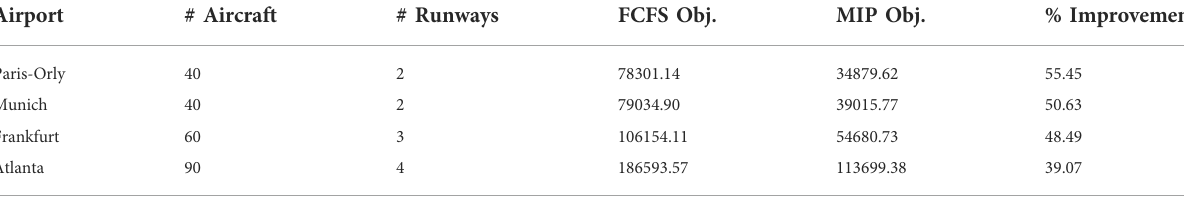
TABLE 6 Comparison of optimal schedules with the FCFS heuristics for different airports. Airport # Aircraft # Runways FCFS Obj. MIP Obj. %